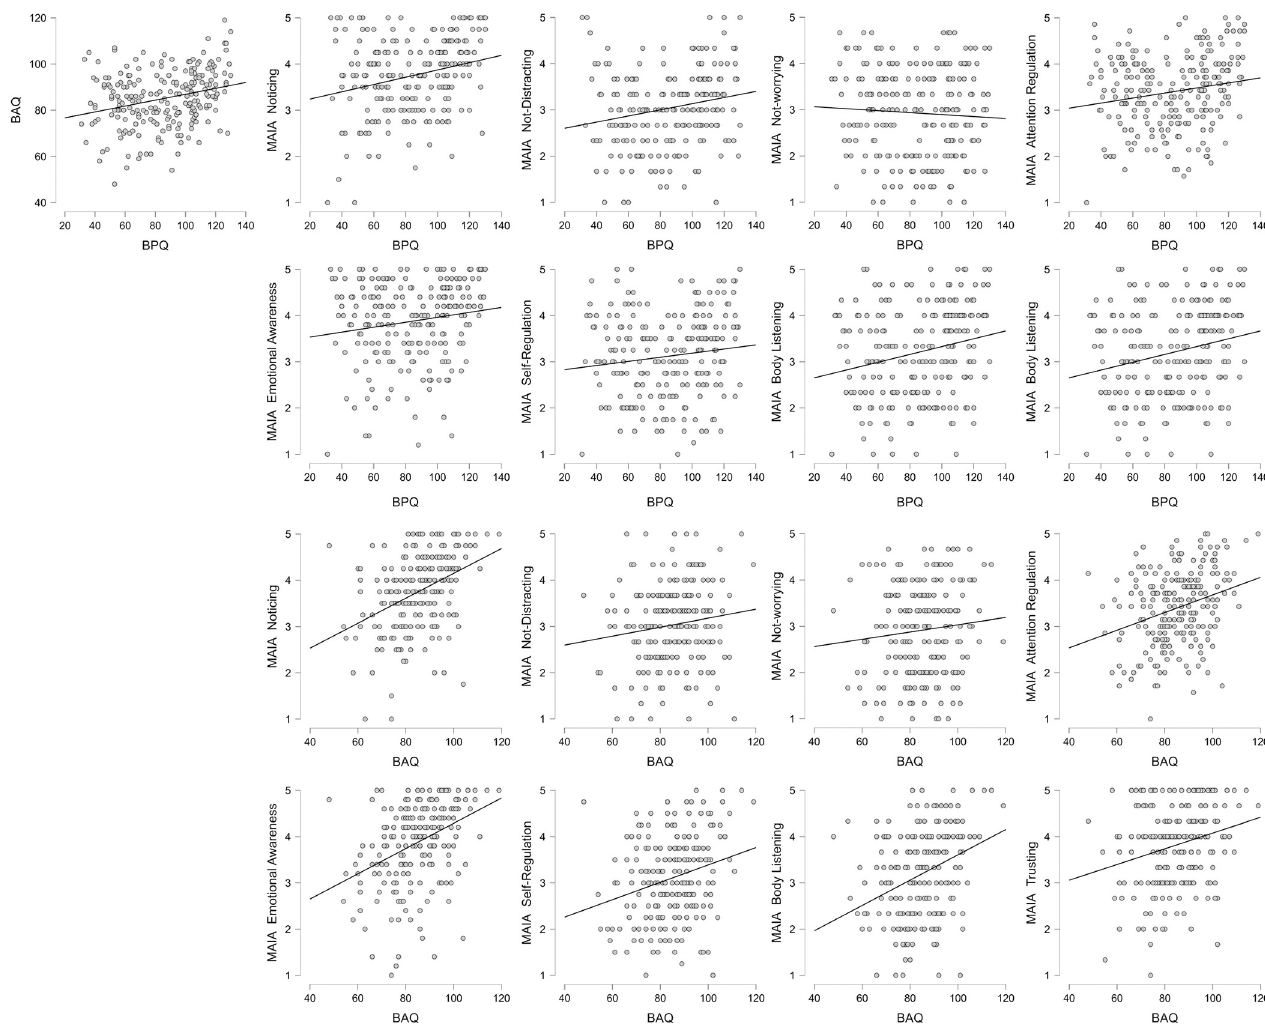
Fig 1. Scatter plots presenting the pairwise associations between the assessed questionnaires of ISb. BPQ = Body Awareness Subscale of the short form of Body Perception Questionnaire; BAQ = Body Awareness Questionnaire; MAIA = Multidimensional Assessment of Interoceptive Awareness.